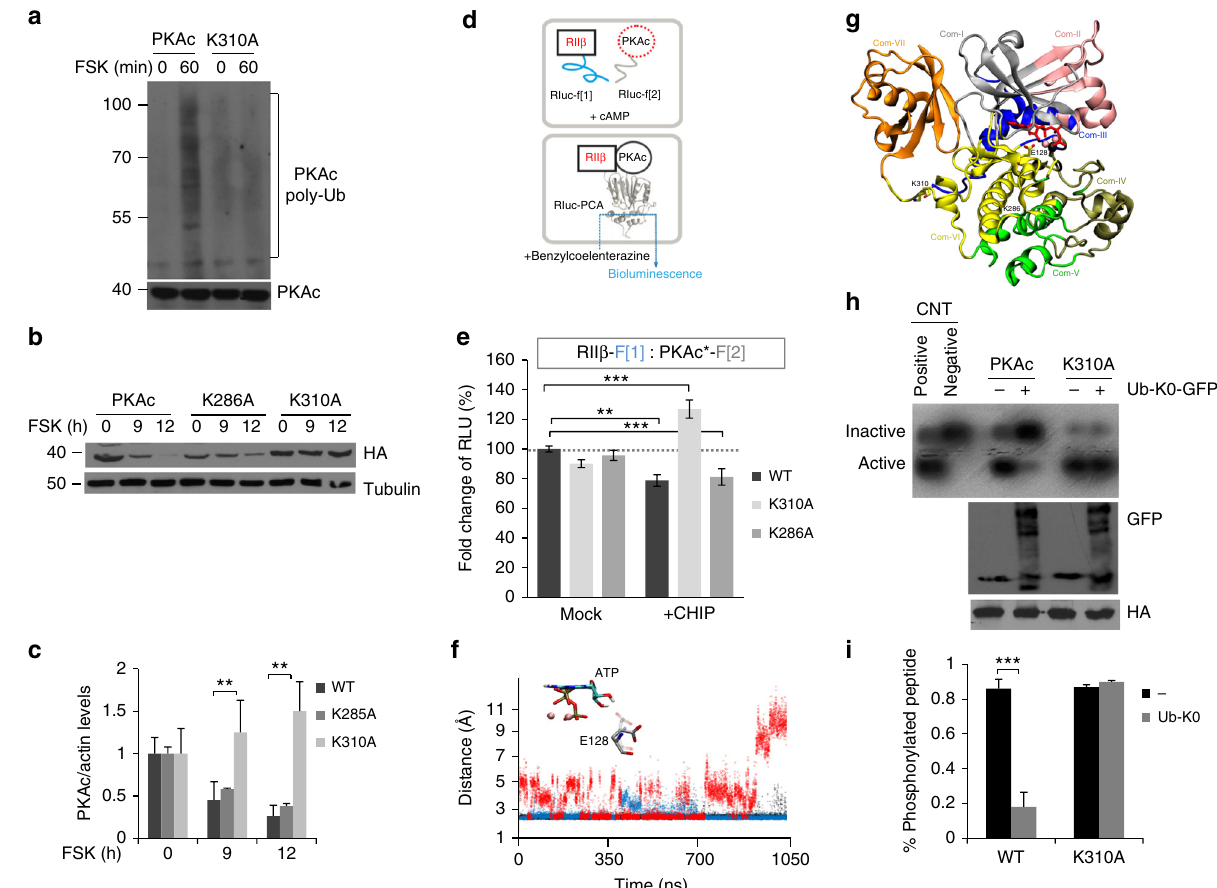
Fig. 5 Ubiquitylation of K310 affects PKAc dynamics and activity. a Cells were transiently co-transfected with myc-tagged PKAc construct (either wild type or K310A mutant) and HA-ubiquitin. Twenty-four hour after transfection, cells were treated with MG132 (20 µ M) for 1 h and then stimulated with FSK (40 μ M/60 min). Lysates were subjected to immunoprecipitation with anti-PKAc, and immunoblotted with anti-PKAc and anti-HA antibodies. b Cells transfected with HA-tagged PKAc vectors (wild type, K286A or K310A) were serum deprived overnight and stimulated with FSK (40 μ M). c Quantitative analysis of the experiments shown in b . A mean value ± S.E.M. of three independent experiments is reported (statistical test: ANOVA, ** p < 0.05). d, e PPI reporter analyses of transiently coexpressed R luc PCA reporter constructs in the presence or absence of myc-tagged CHIP (ratio of transfection 1:1:2). Quanti fi cation of fi ve independent experiments (mean ± SEM) are shown. Student ’ s two-tailed t test was used to evaluate statistical signi fi cance. Con fi dence level: ** P < 0.01, *** P < 0.001. f Time evolution of distances between the carboxyl group of E128 and the 2 ′ hydroxyl of ATP ribose in free (black), K286-Ub (blue) and K310-Ub (red) PKAc and licorice representation of the conformational switch observed for E128. g . Community maps retrieved by the dynamical network analysis for K310-Ub. Communities color code is detailed in Supplementary Tables 2 and 3. ATP is depicted in red stick, and Mg ++ ions are depicted in pink spheres. The Girvan – Newman algorithm split the dynamic network of K310-Ub PKAc into seven communities (from Com-I to Com-VII). h Cells were transfected with PKAc vectors (either wild type or the K310 mutant), in the presence or absence of Ub-K0-GFP mutant, stimulated with FSK (40 µ M/30 min) to promote ubiquitylation of PKAc and lysed. Lysates were subjected to in vitro kinase assays. i PKAc activity is presented as the percentage of phosphorylated peptide calculated as the ratio between phosphorylated peptide signal and total signal. Data are expressed as mean value ± S.E.M. of four independent experiments. Student ’ s t test, *** P < 0.001. An aliquot of the lysates was subjected to immunoblot analysis with anti-HA (fo PKAc) and anti-GFP for 1 h to induce ubiquitylation of PKAc, harvested and lysed. Cell lysates were subjected to in vitro PKA enzymatic assays. The results demonstrate that coexpression of Ub-K0 mutant drama- tically inhibited the activity of wild-type PKAc (Fig. 5h, i). In contrast, Ub-K0 protein had no signi fi cant effects on the activity of the coexpressed K310A mutant (Fig. 5h, i). These results indicate that K310 monoubiquitylation acts as inhibitory mechanism of PKAc activity in course of cAMP stimulation.